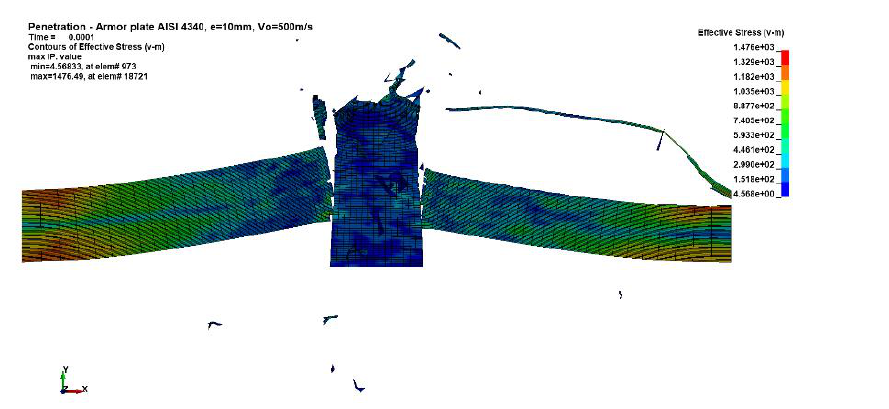
Figure 7 – Von Misses equivalent stress, time of analysis 0.1 ms – Model 1 Рис. 7 – Von Misses эквивалентное напряжение, время анализа 0.1 ms – Модель 1 Слика 7 – Von Misses-ов еквивалентни напон, време анализе 0,1 ms – модел 1